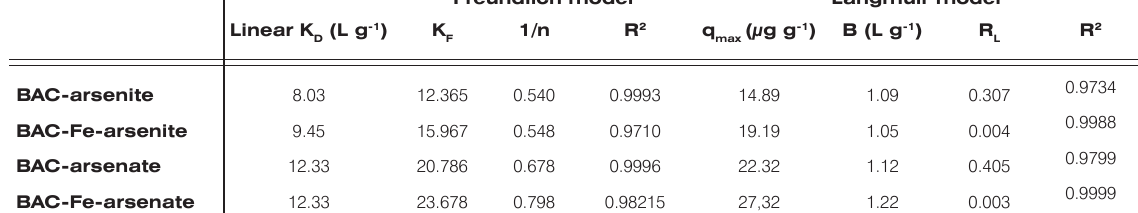
Table 3. Isotherm parameters of arsenite and arsenate adsorption on activated carbon from bamboo and activated carbon modified with iron. Freundlich model Langmuir model